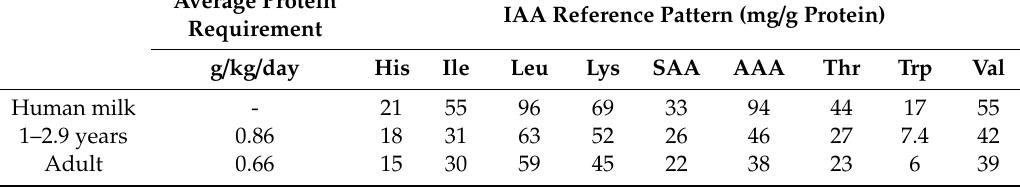
Table 1. Indispensable amino acids (IAA) reference pattern for infants and children derived from mother’s milk composition and calculated by the factorial method for young children 1–2.9 years in comparison to adults